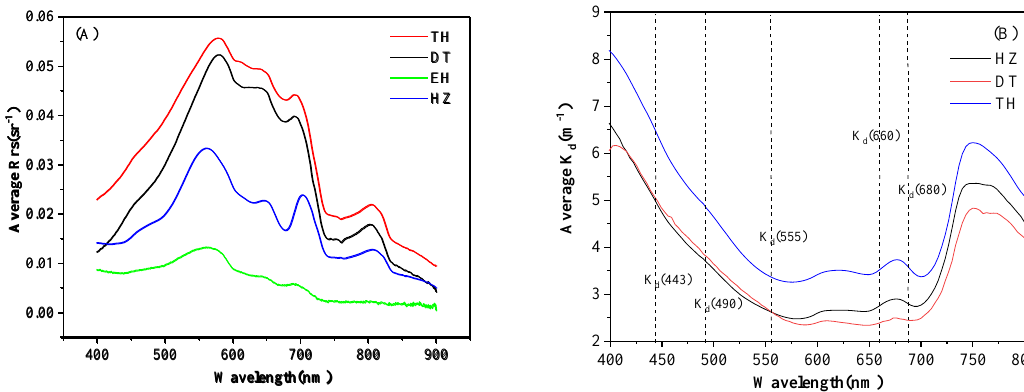
Figure 3. Average Rrs ( A ) and K d (B) in Lake Hongze (HZ), Lake Taihu (TH), Lake Dongting (DT), and Lake Erhai (EH), respectively. The K d ( 555 ) is the minimum K d value within the visible domain for GOCI ( B ).